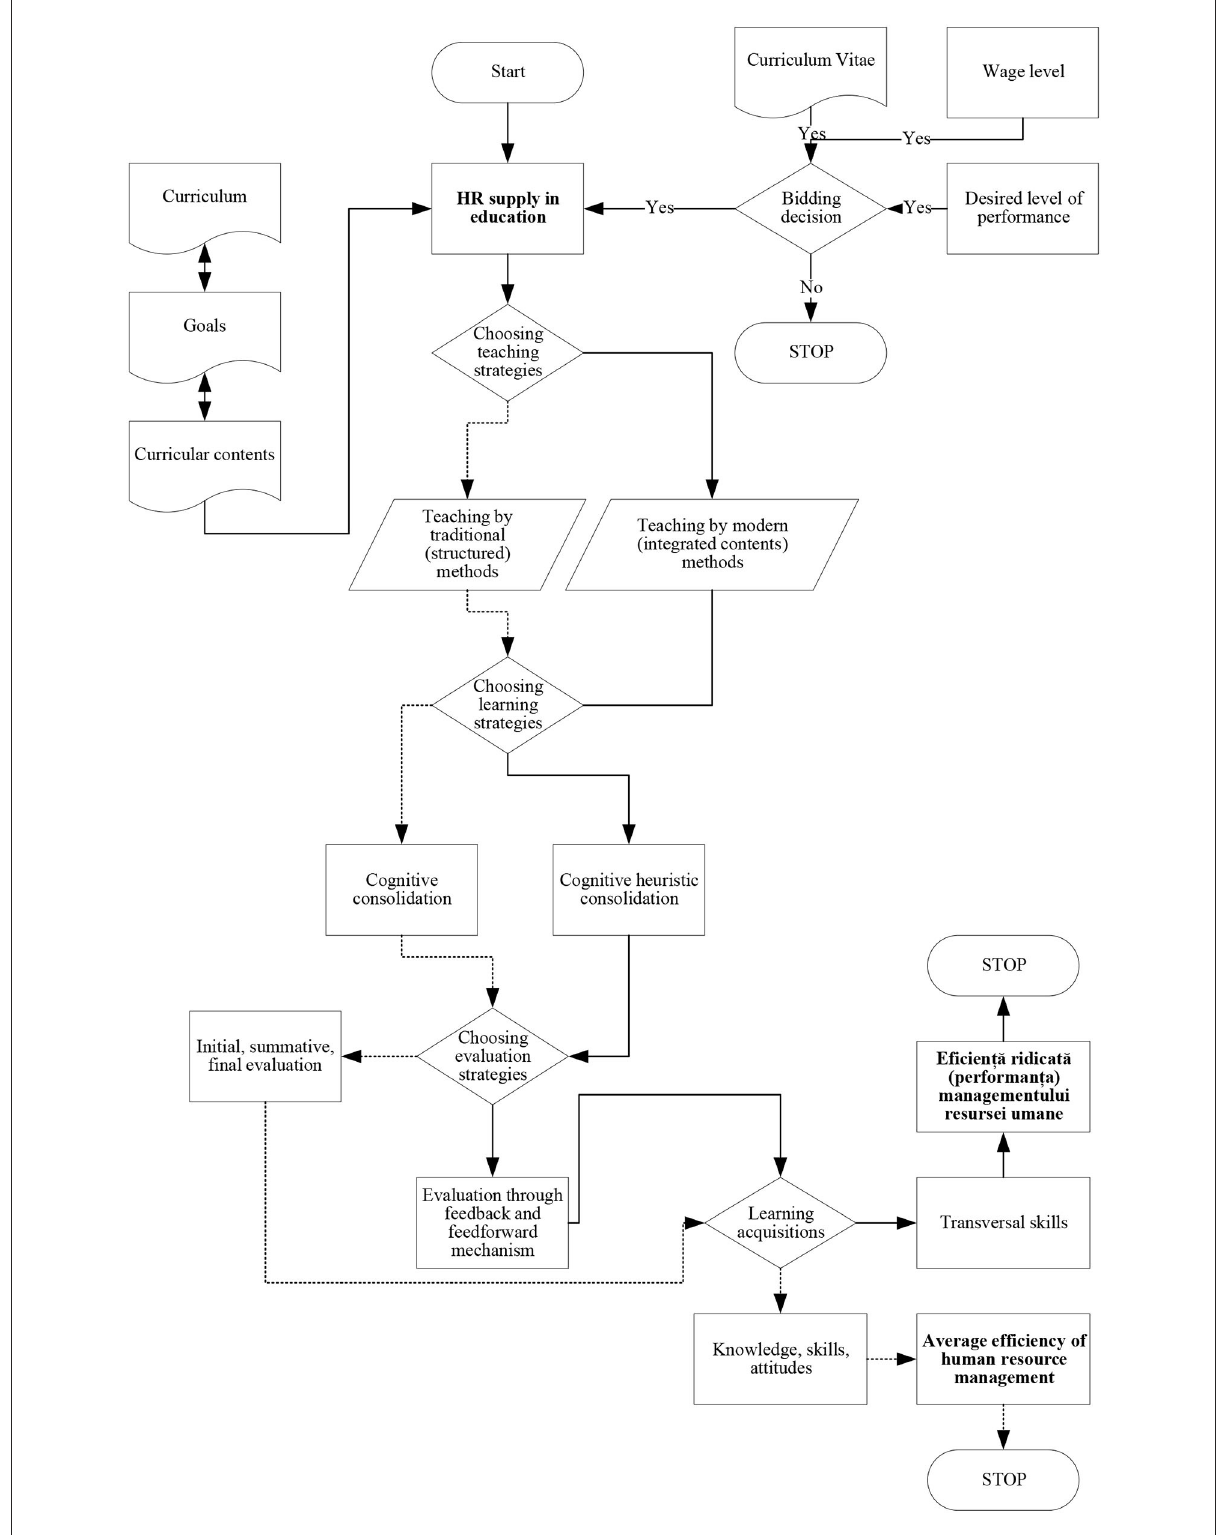
FIGURE2 Methodological aspects (logical